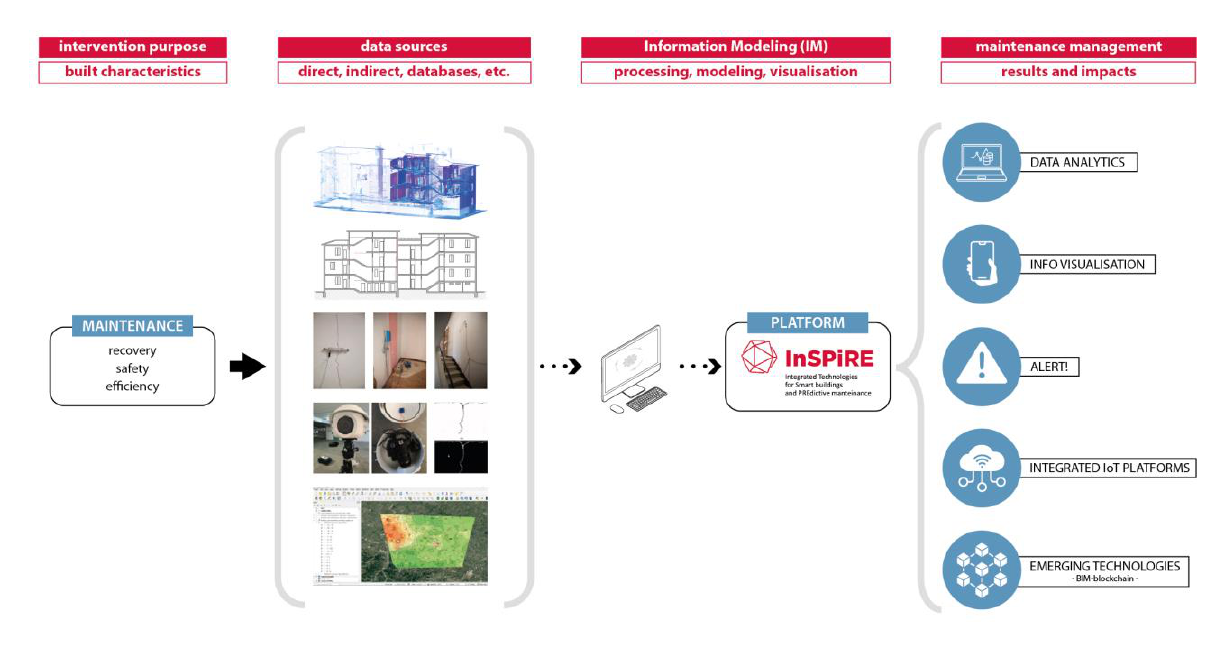
Figure 2. Data integration from various sources for predictive maintenance of the built